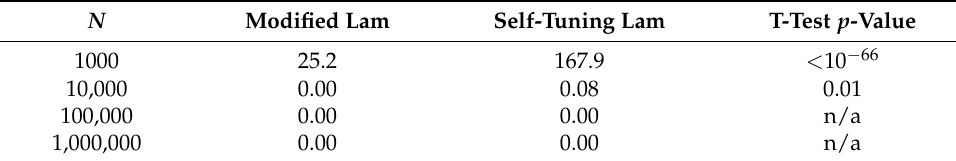
Table 3. Average solution cost for the OneMax problem, case when each 0-bit costs 10. N